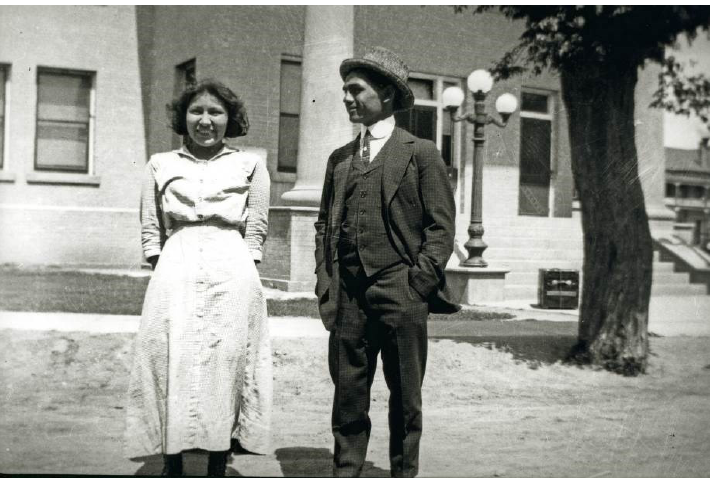
Figure 10. Nettie Odlety and Parker McKenzie in front of the Administration Building, March 1916. Unknown Photographer. Parker McKenzie Collection. Courtesy of the Oklahoma Historical